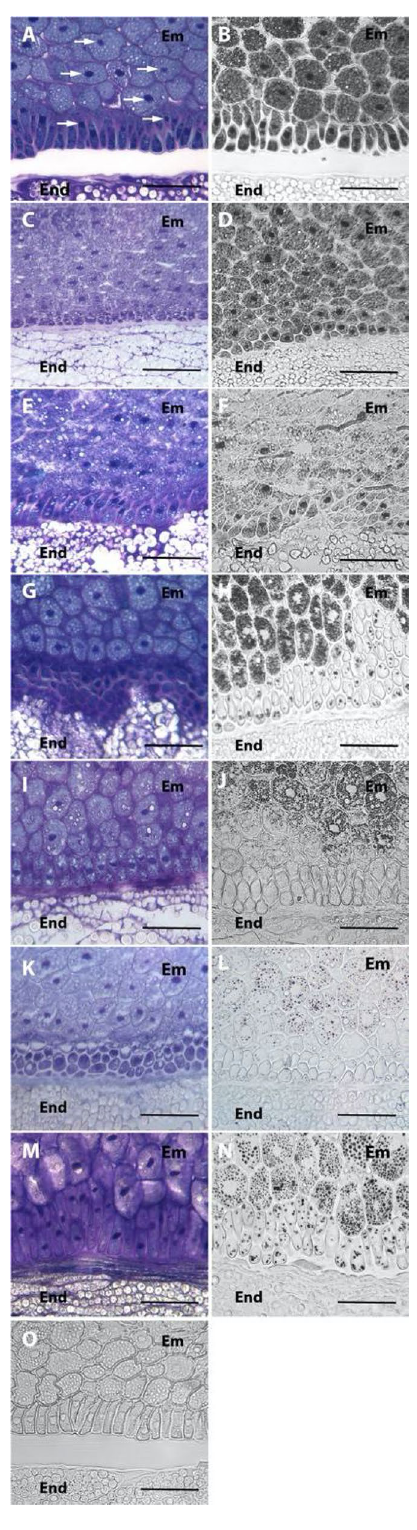
Figure 2. Iron distribution in kernels from archaeological sites and modern samples from Tarapacá revealed by Perls/DAB staining. ( A – B , O ) pictures from Ramaditas, ( C , D ) pictures from Pintados, ( E , F ) pictures from Tarapacá 40, ( G , H ) pictures from Tarapacá 13, ( I , J ) pictures from Tarapacá Viejo, ( K , L ) pictures from Alero Cerro Colorado 7, ( M , N ) pictures from modern sample. ( A , C , E , G , I , K , M ) correspond to toluidine blue stained sections, used to verify integrity of cells and subcellular structures in the section. ( B , D , F , H , J , L , N ) correspond to sections stained by Perls/DAB in order to detect iron, the black labeling corresponds to iron. ( O ) is a negative control of the Perls/DAB staining (without K-ferrocyanide). For all pictures, embryo and endosperm correspond to Em and End, respectively. Arrows indicate some nuclei (for simplicity only in A ). Bars: 50